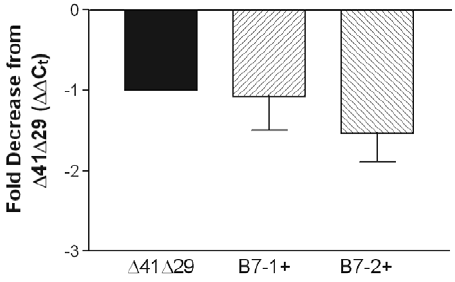
Figure 9. Relative levels of HSV-1 DNA in trigeminal ganglia during latency. Groups of mice immunized with the medium dose of virus were challenged with 8 6 10 5 pfu HSV-1 mP 1 month later. Four weeks after challenge, TG were removed and DNA was extracted. Relative viral DNA content was assessed by real-time PCR using primers for UL50 after normalization to the signal for GAPDH. Data represent the relative mean fold decrease ( 6 SD) of latent genome in 11 TG from D 41 D 29B7-1- and 11 TG from D 41 D 29B7-2-immunized mice compared with 11 TG from D 41 D 29-immunized mice (set to 1). P . 0.05 by ANOVA.